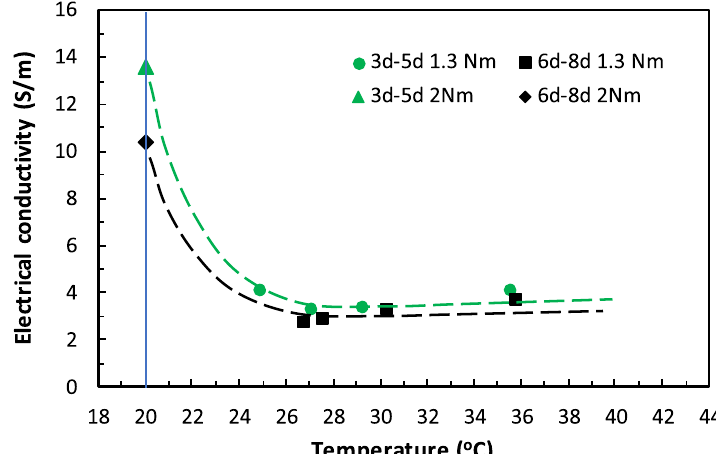
Fig. 14 Electrical conductivities of unpainted carbon/epoxy laminates in TTT direction